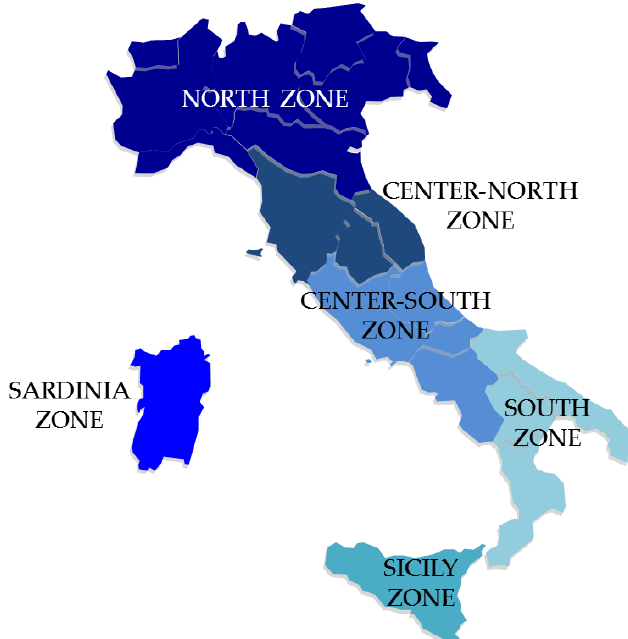
Figure 7. Division of the Italian territory in six market zones [51].